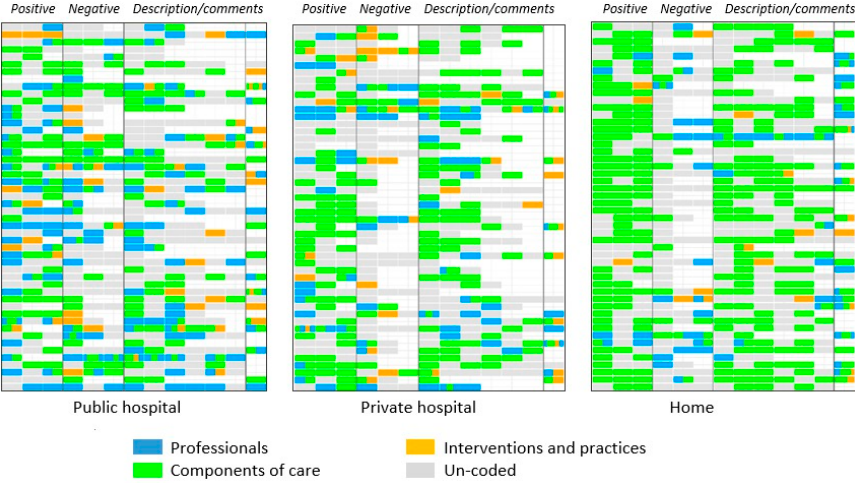
Figure 4. Comparing the distribution of categories by place of